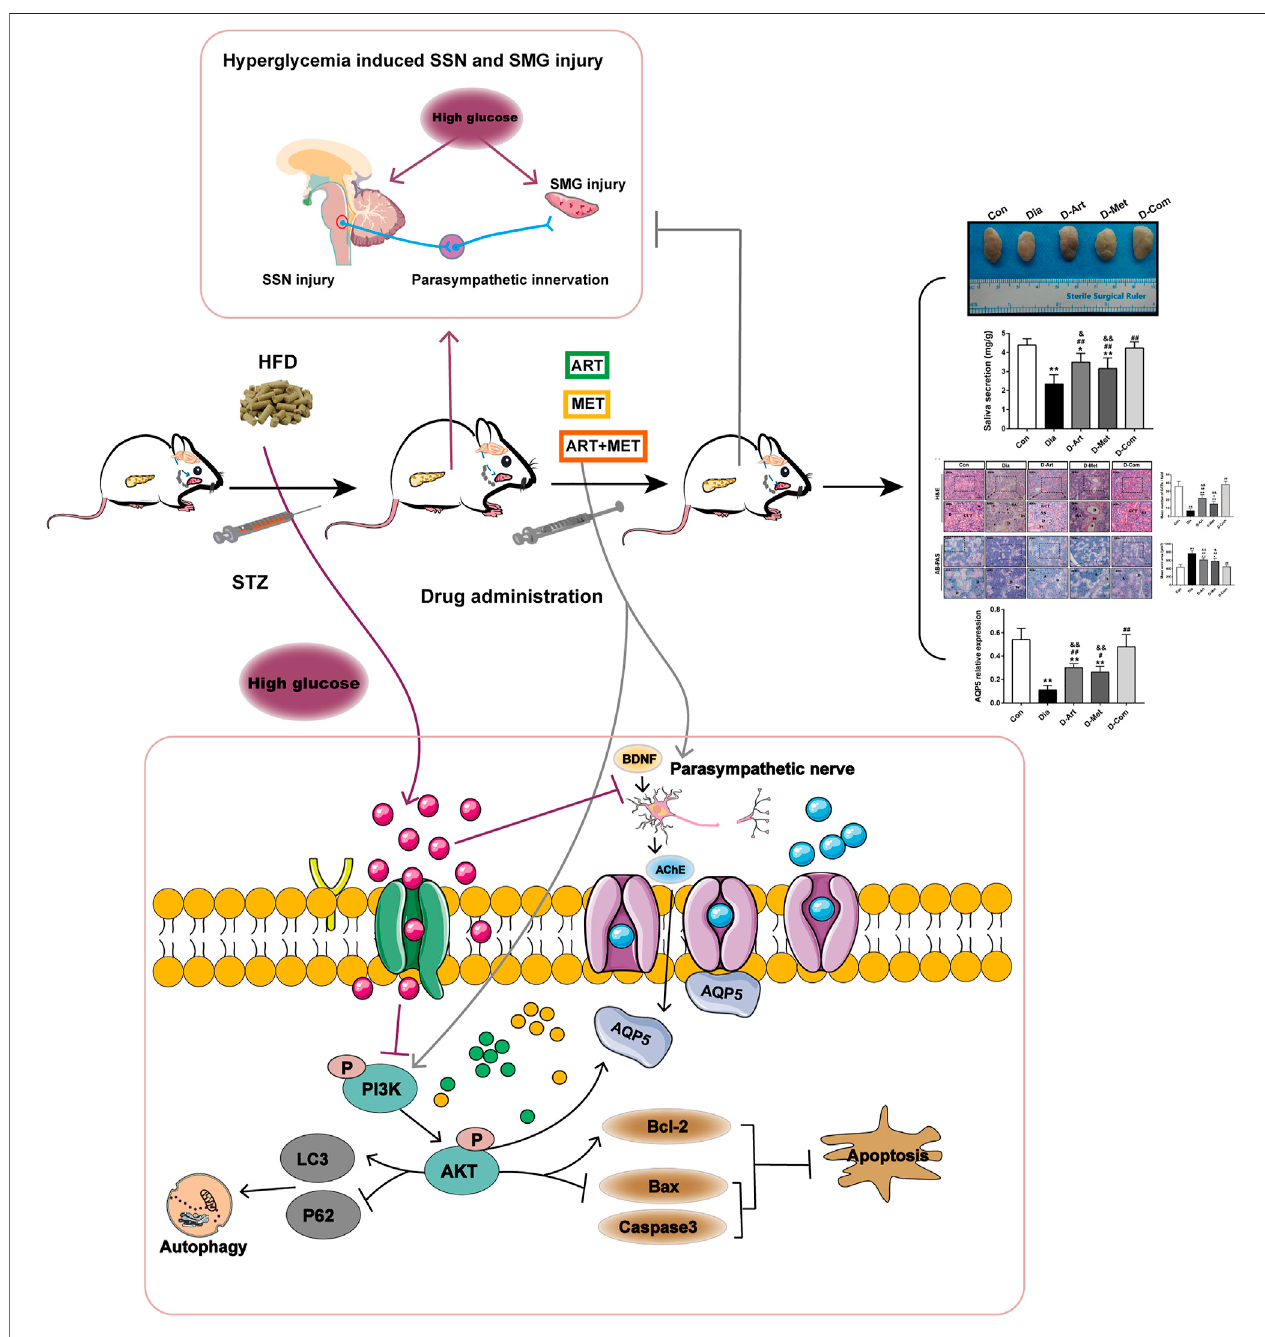
FIGURE 9 | Schematic diagram of the proposed mechanisms through which ART and Met synergistically ameliorate xerostomia in HFD/STZ-induced T2DM rats viarescuingcentral SSNandSMGdamageinducedbyhyperglycemia.Ontheonehand,ART/MetattenuatedSMGdamagethoughregulatingthePI3K/Aktpathwayto inhibitapoptosisandautophagyofSMGs.Ontheotherhand,ART/Mettreatmentpreservedperipheralparasympatheticinnervation(AChEandBDNF)inSGstoalleviate diabetes-induced hyposalivation likely through alleviating central SSN damage. T2DM, type 2 diabetes mellitus.